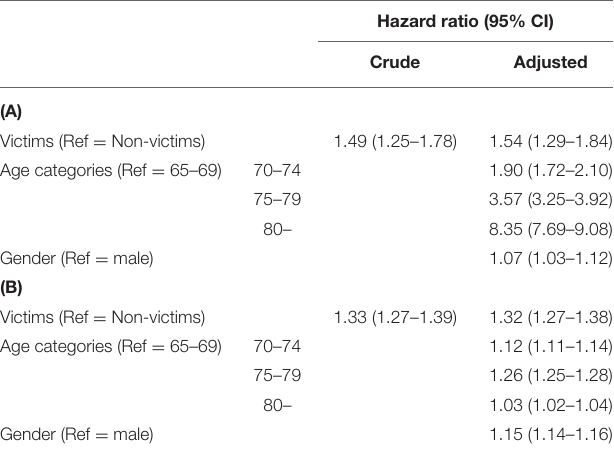
TABLE 2 | Hazard ratios and 95% confidence intervals for a new prescription (A) Yokukansan, (B) Other Kampo drugs.